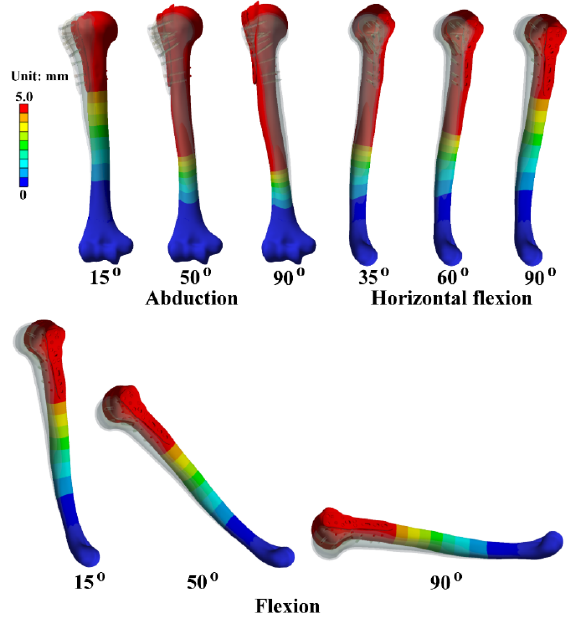
Figure 5. Total deformation of humerus under mechanical testing loading.